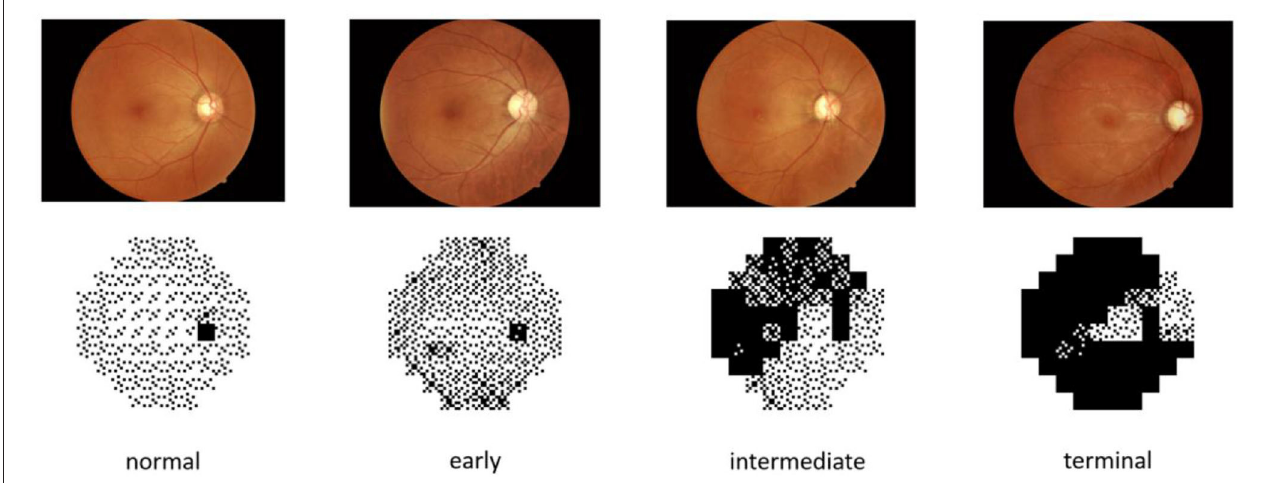
FIGURE 2 | Samples of different